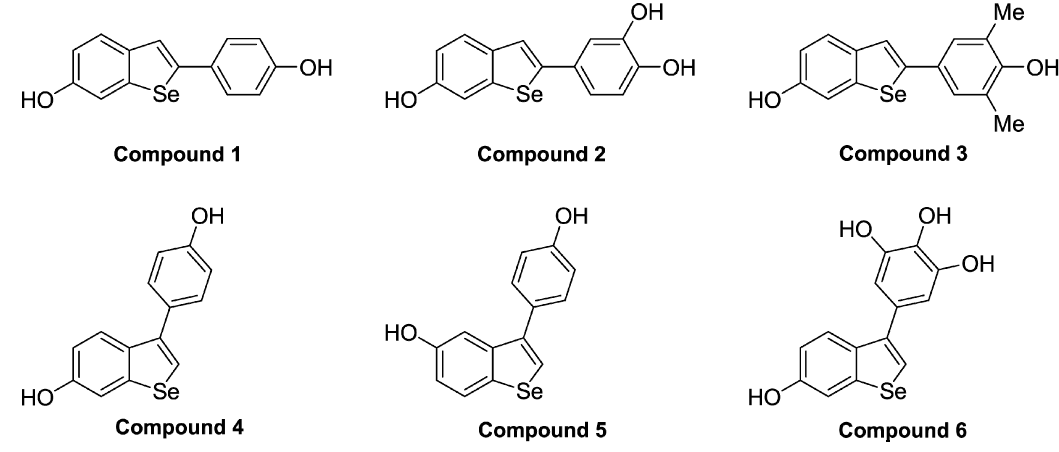
Figure 2. Chemical structures of benzo[ b ]selenophenes used in this study.